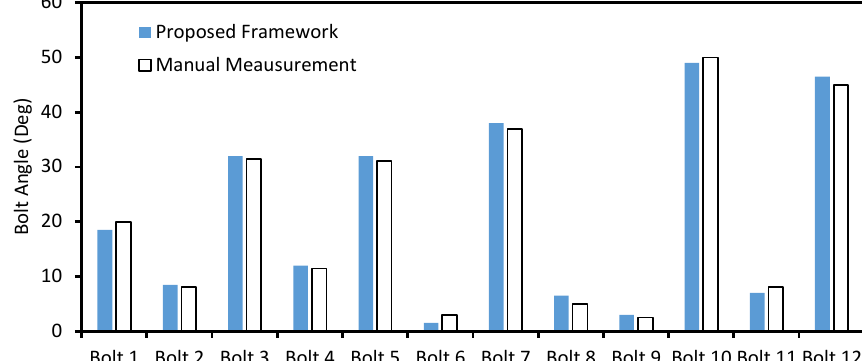
Figure 16. Results of the vision-based bolt-loosening monitoring method.